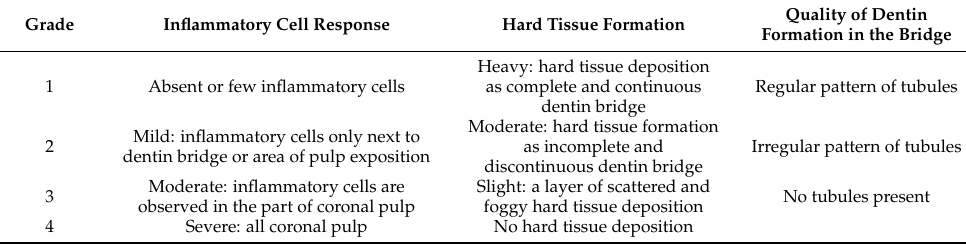
Table 1. Histological evaluation scoring protocol of pulp response to direct pulp